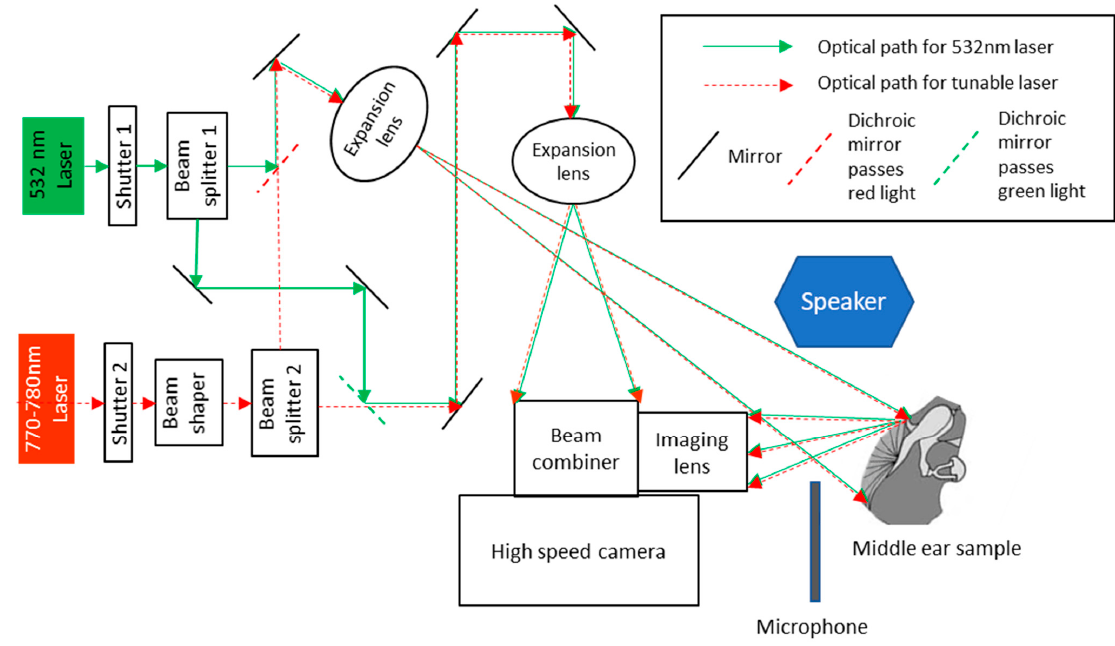
Figure 1. Schematic of high-speed digital holographic (HDH) system [4]. The 532 nm laser is used for displacement measurements, and the 770–780 nm tunable laser is used for shape measurements. The two lasers are coupled into the same optical path to ensure the shape and displacement measurements are in the same coordinate system avoiding the need for image